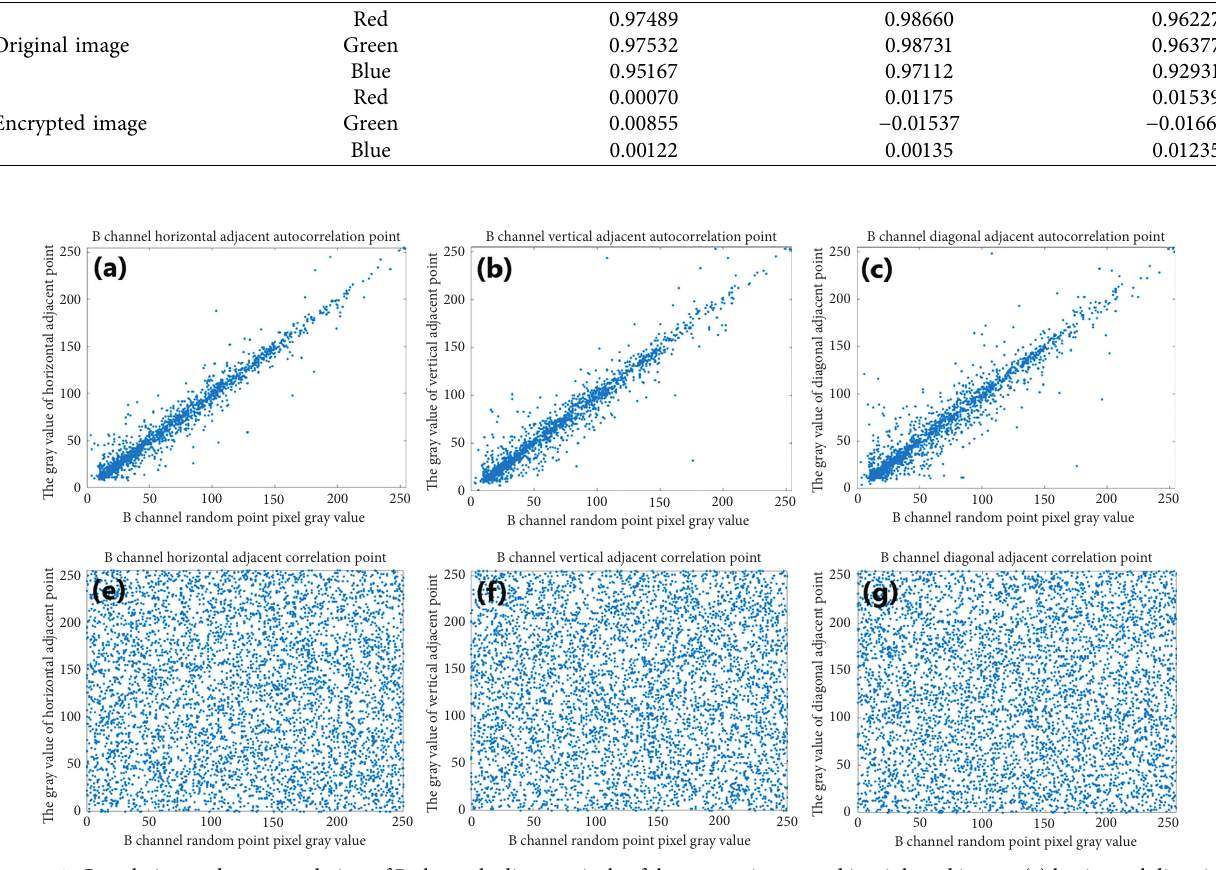
Figure 9: Correlation and autocorrelation of R channel adjacent pixels of the pepper image and its ciphered image: (a) horizontal direction of the pepper image; (b) vertical direction of the pepper image; (c) diagonal direction of the pepper image; (d) horizontal direction of the pepper ciphered image; (e) vertical direction of the pepper ciphered image; (f) diagonal direction of the pepper ciphered